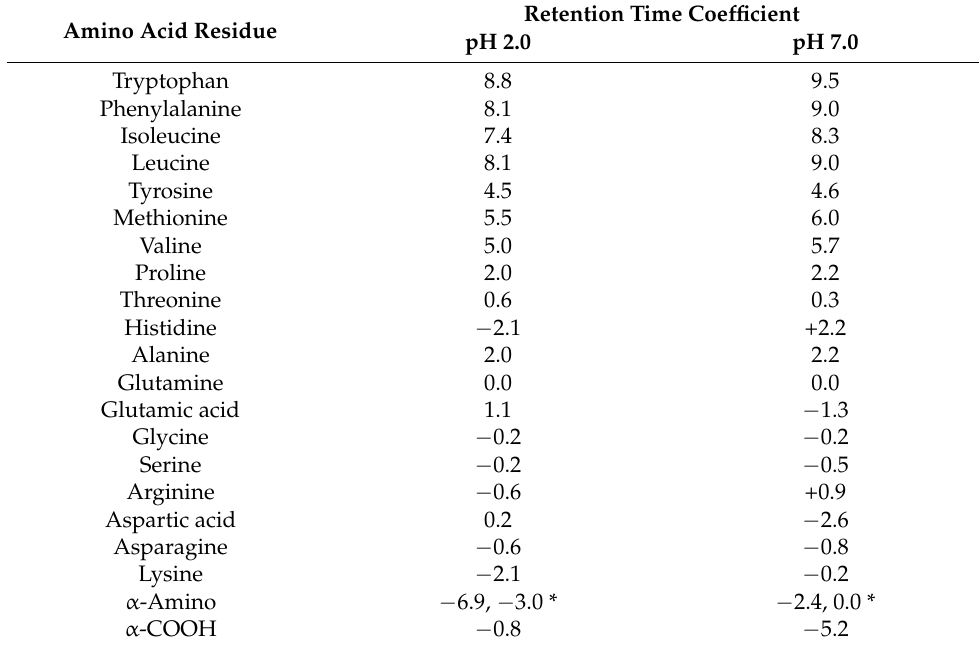
Table 1. Retention time for pH 2.0 and 7.0